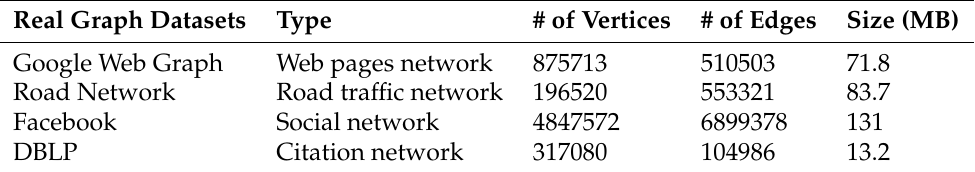
Table 3. Dataset statistics.